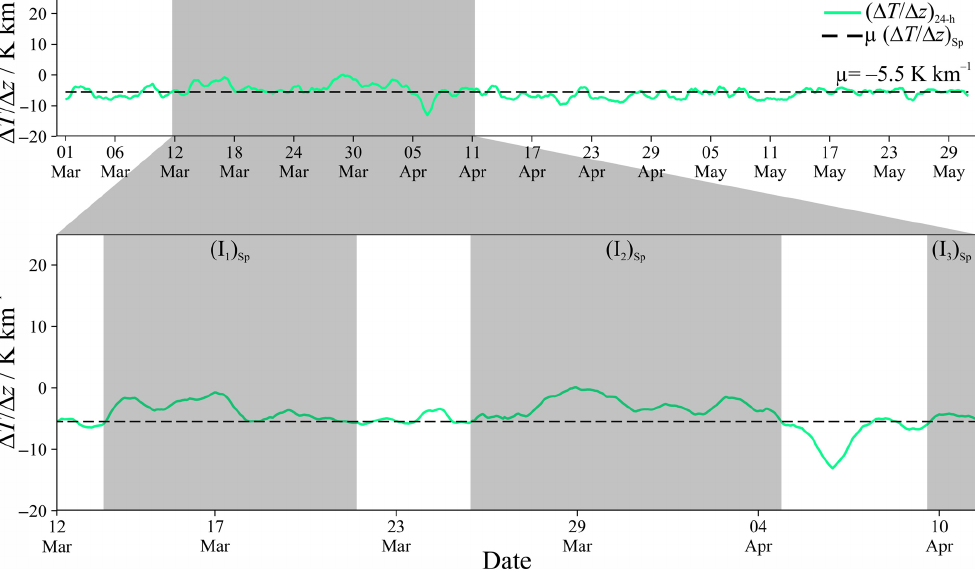
(I i ) W except (I 4 ) W